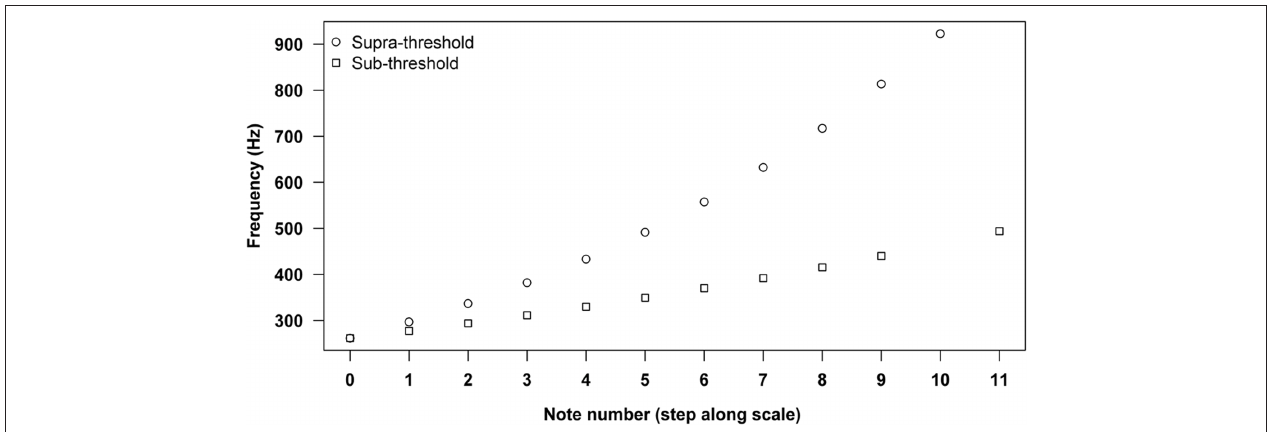
FiGuRe 1 | Frequency of tones used in the sub-threshold and supra-threshold tonal conditions. Note numbers 0–9 and 11 in the sub-threshold condition correspond to C4 to A4 and B4 while note numbers 0–10 in the supra-threshold condition correspond to tones from a novel scale obtained by dividing the two-octave span from C4 (261.3 Hz) into 11 evenly log-spaced divisions.